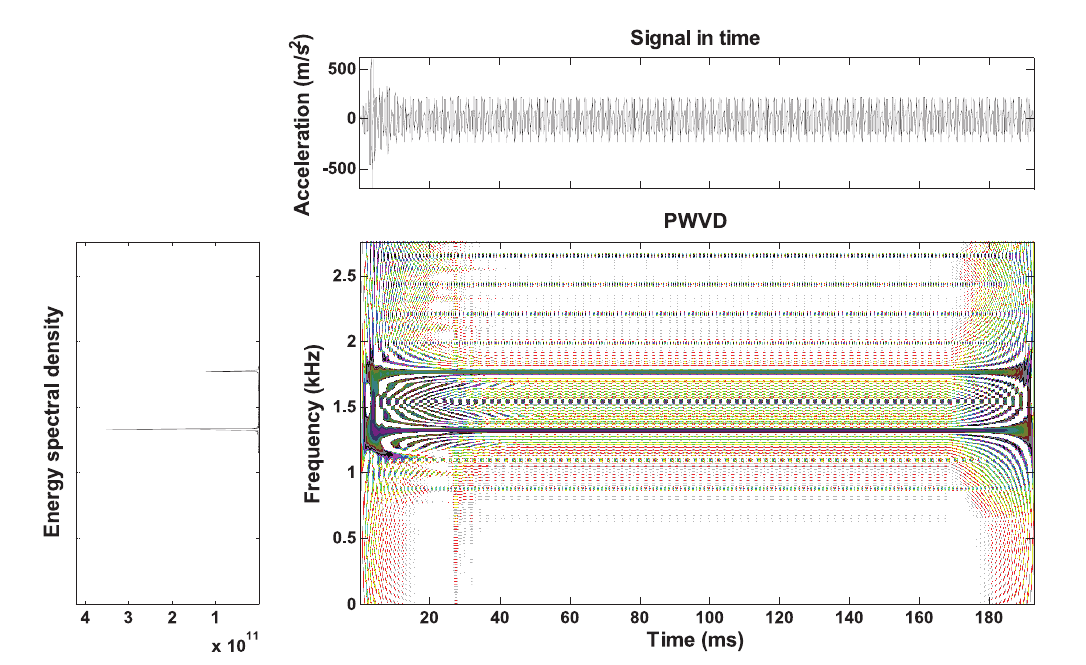
Fig. 13. SWVD of the pinion bearing acceleration for a constant load.